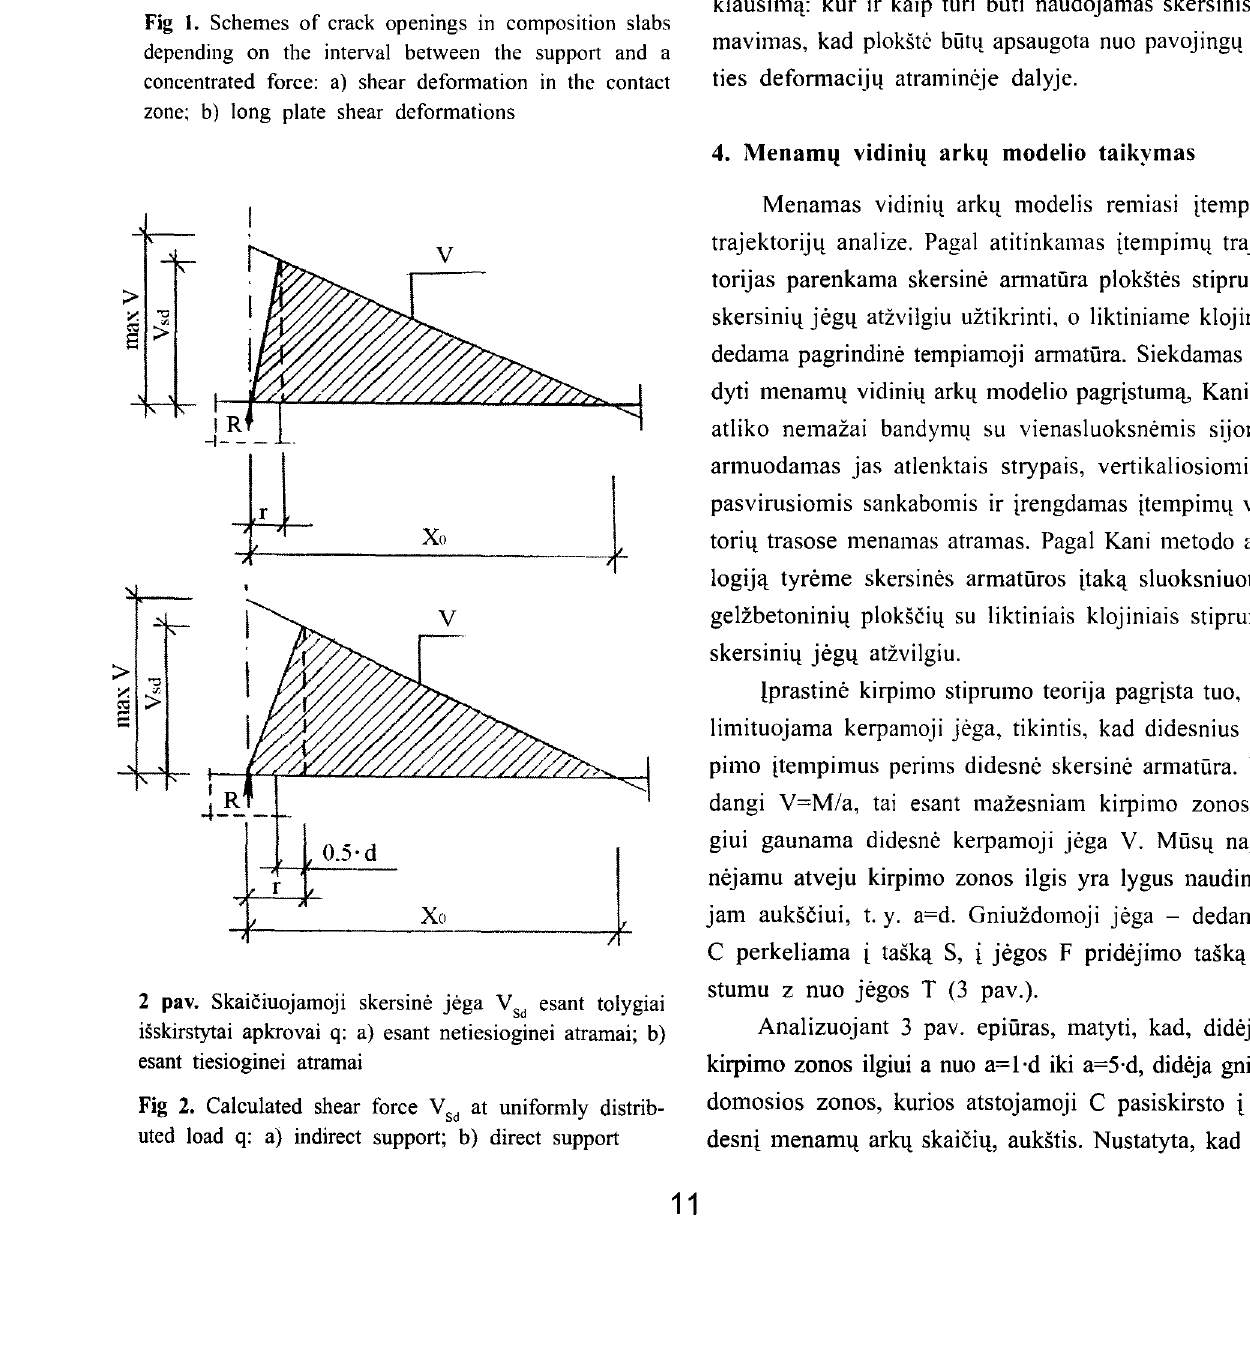
at uniformly distrib 5 d